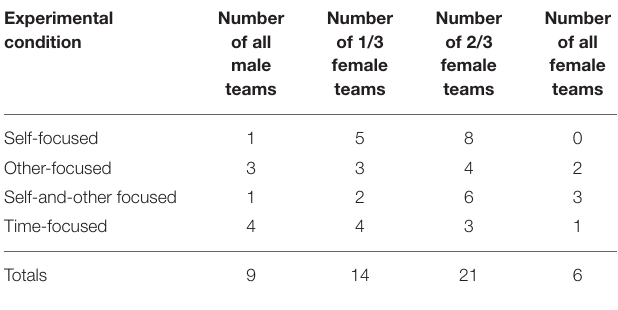
TABLE 1 | Team gender composition by experimental condition. Experimental